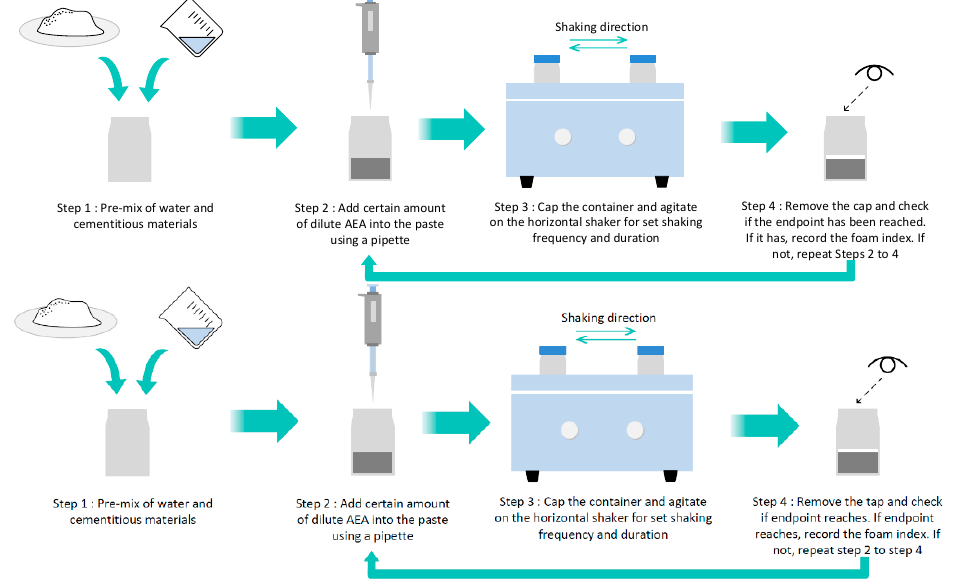
Figure 3. Schematic diagram of the foam index test procedure.